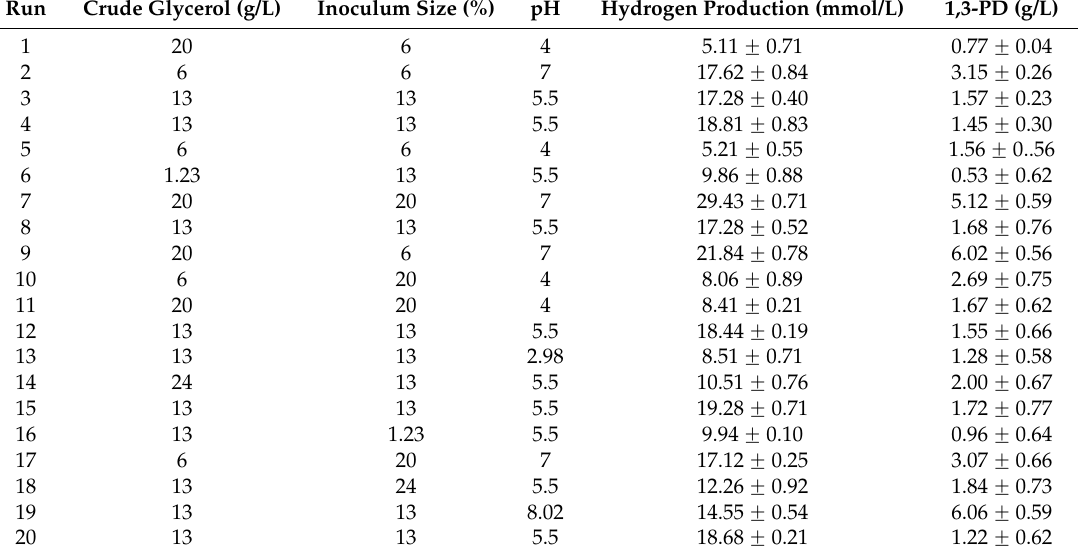
Table 2. The experimental runs of central composite design across crude glycerol concentration (g/L), different inoculum size (%), varying pH and experimental runs in terms of hydrogen production (mmol/L) and 1,3-PD concentration (g/L).